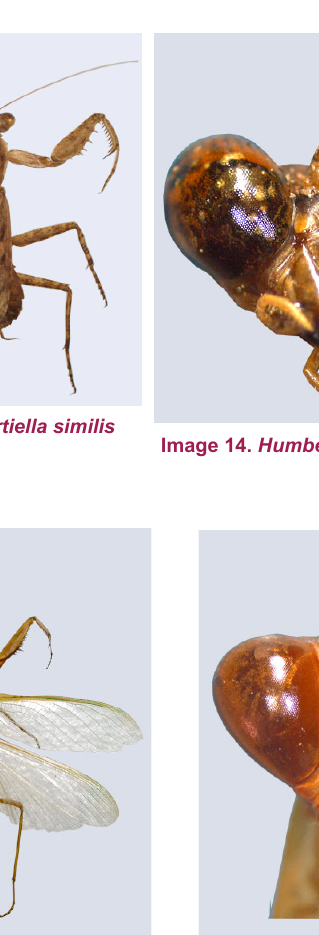
Image 15. Humbertiella similis Fore-leg Image 16. Hierodula ventralis Male Image 17. Hierodula ventralis Frontal